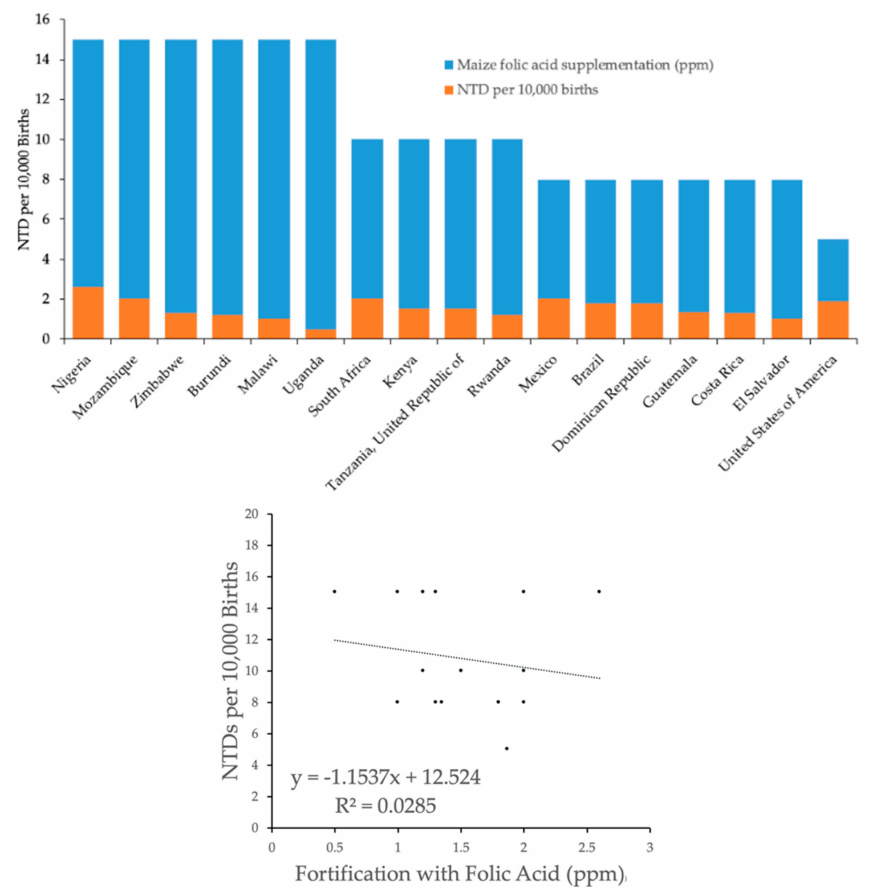
Figure 2. Prevalence of NTDs as a function of folic acid fortification levels in maize. The number of NTDs per 10,000 births was plotted (blue bars) versus country ( n = 17). Folic acid fortification levels of maize in ppm (orange bars) were superimposed on NTD prevalence. Linear regression analysis indicates a regression coe ffi cient (a) of − 1.15.